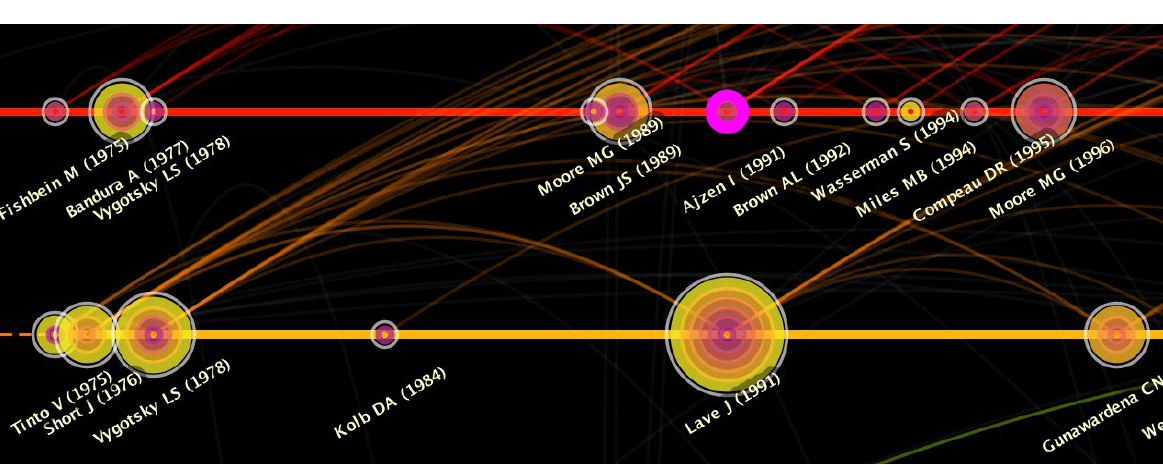
Snapshot of Timeline Visualization From 1970s to